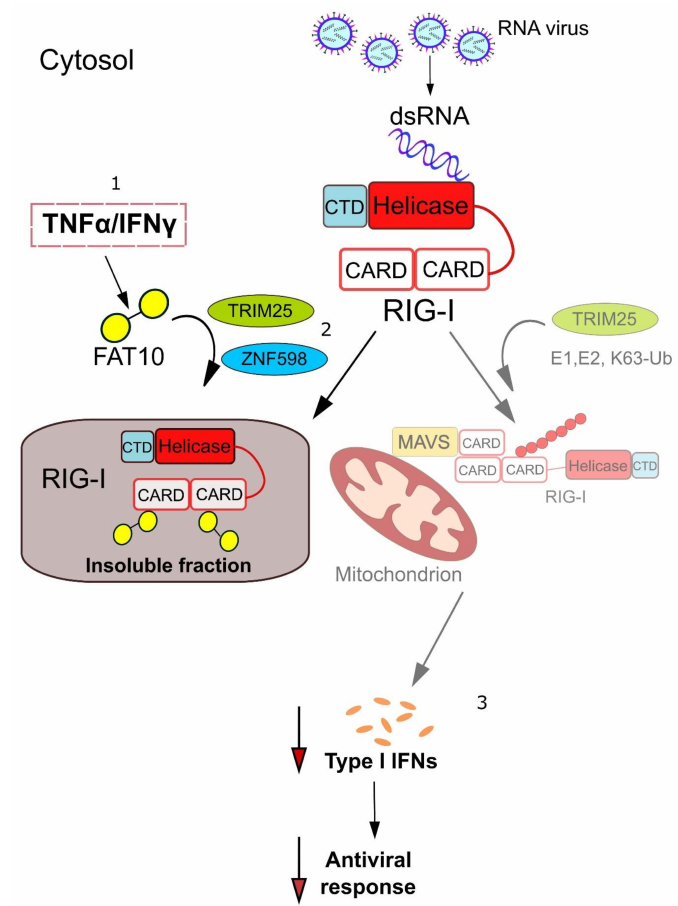
Figure 4. FAT10 inhibits RIG-I activation and impairs the type-I interferon signaling cascade. 1 . The ubiquitin-like modifier FAT10 is expressed upon stimulation with the pro-inflammatory cytokines TNF α / IFN- γ and interacts with the cytosolic RNA sensor RIG-I. 2 . The E3 ligase TRIM25 stabilizes FAT10 bound to RIG-I, which results in its sequestration into a not yet defined insoluble compartment. The E3 ligase ZNF598 promotes the interaction between FAT10 and RIG-I, which in turn reduces the K63-linked ubiquitylation of RIG-I. 3 . This inflammation-mediated inhibition of RIG-I activation impairs the type-I interferon signaling cascade, thus down-modulating the anti-viral response. 5. TRIM25 and ZNF598—Ubiquitin Ligases Involved in the Regulation of RIG-I